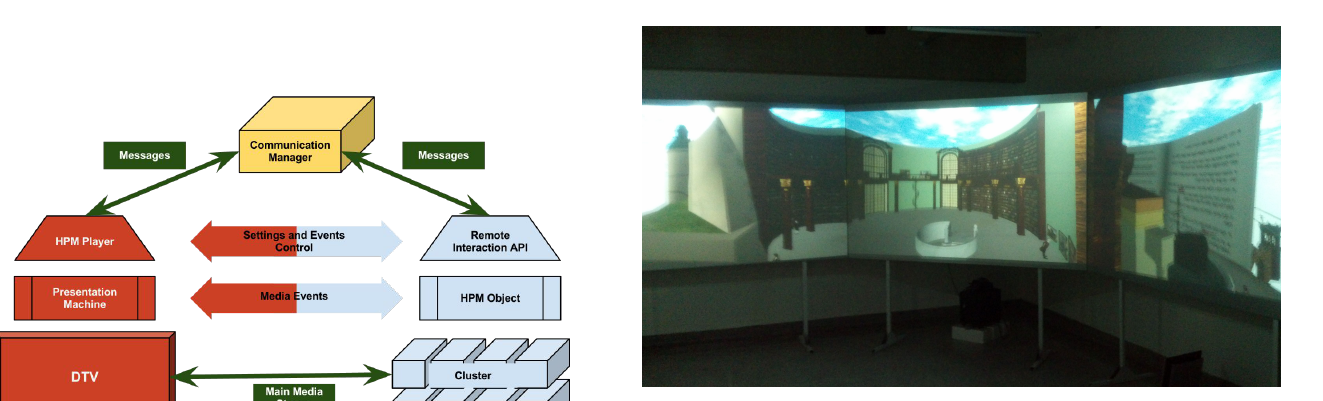
Figure 5. HPM object running on the cluster